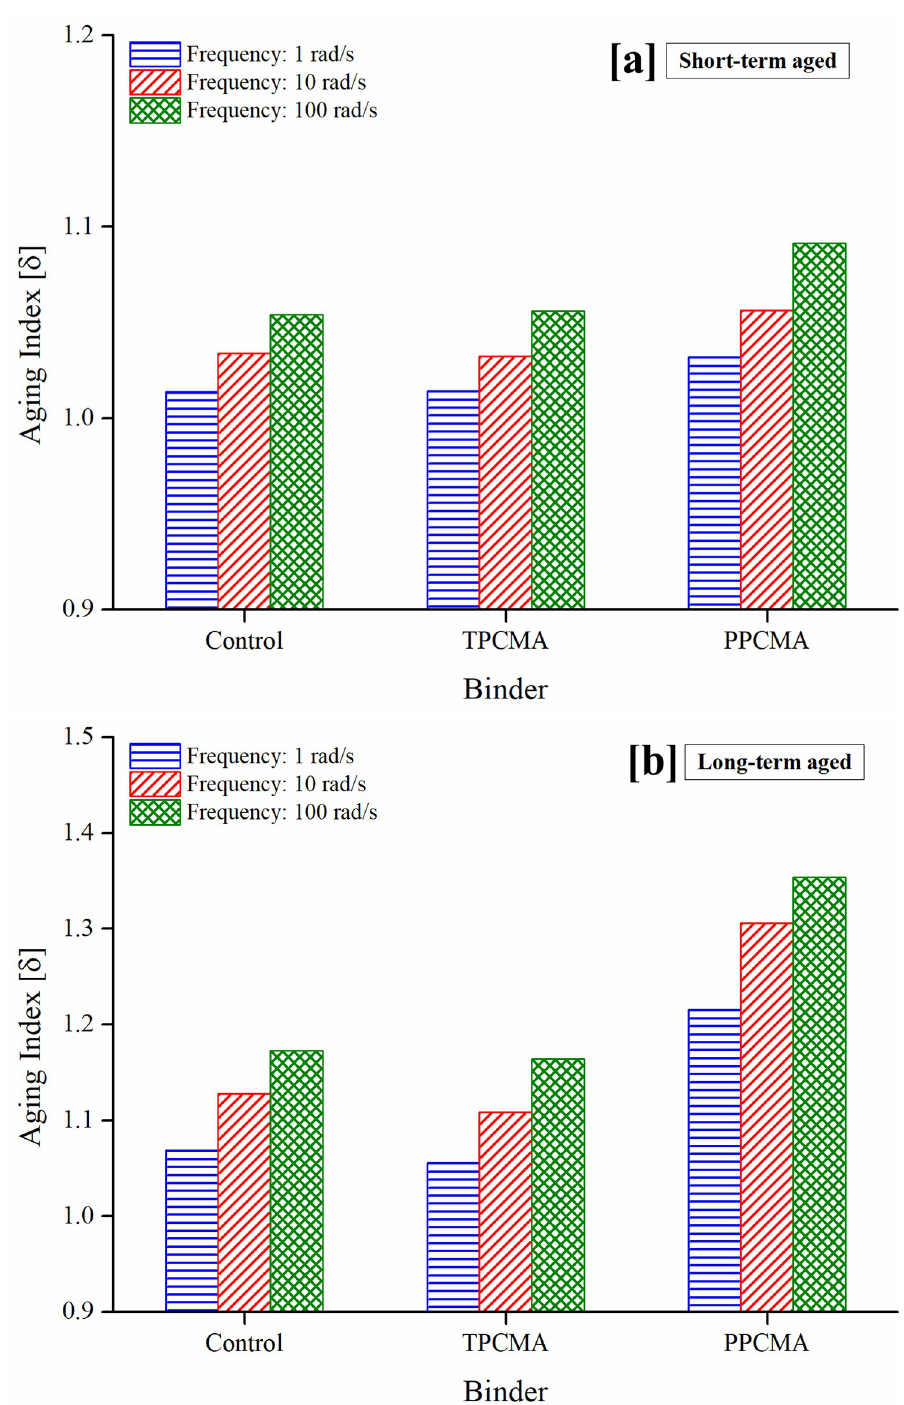
Fig 6. Aging index based on δ under (a) RTFO and (b)